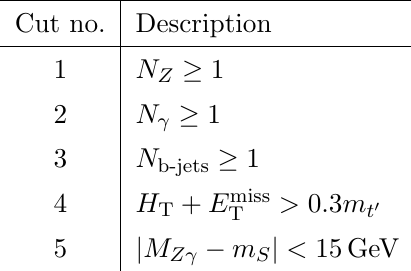
Table 4 . Selection cuts applied to the Z (cid:13) signal region. Details on the cuts are given in the text. Refer to section 4.1 for the de(cid:12)nition of the objects.